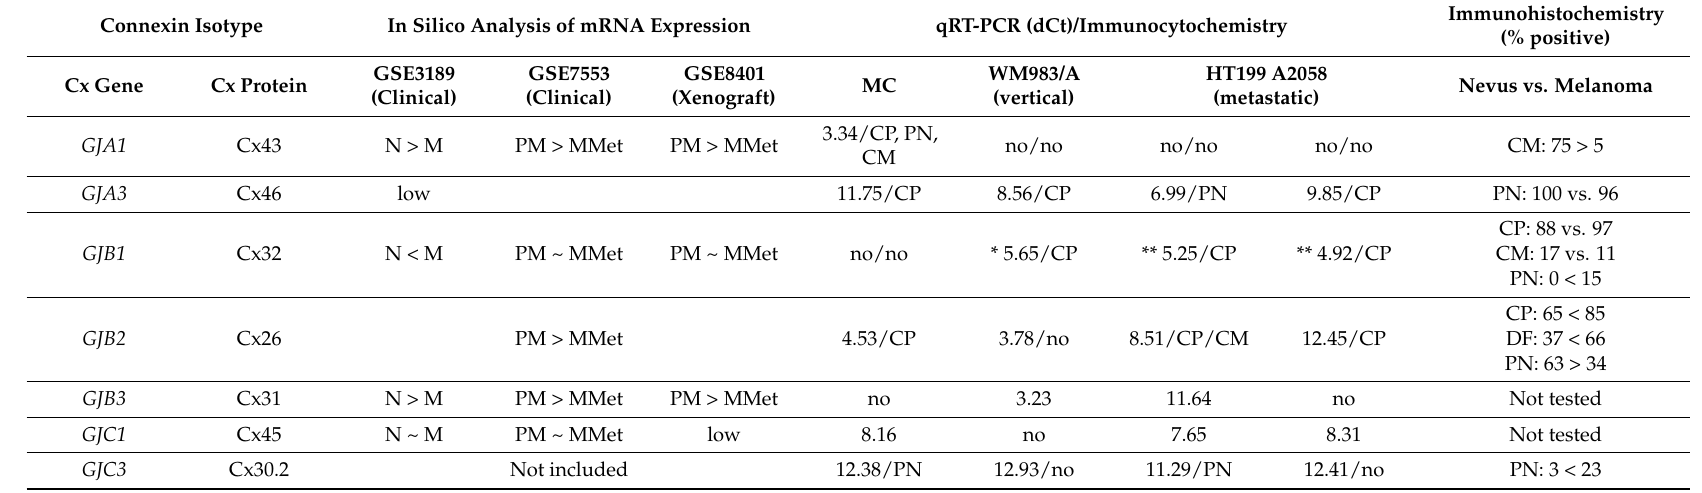
Table 3. Summary of in silico analysis, as well as mRNA and protein expression results of cell culture and tissue